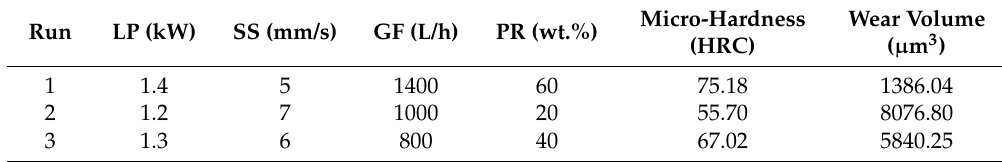
Table 4. CCD experimental design and